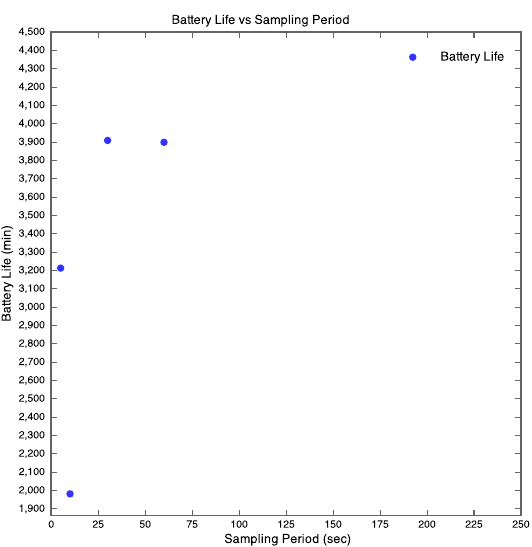
Figure 15. Different sampling periods for Experiment